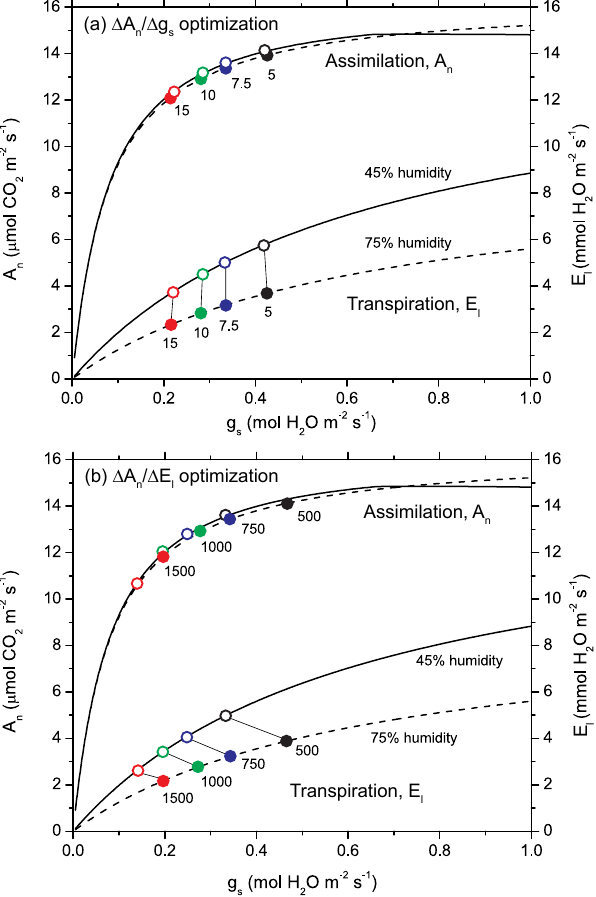
Figure 3. Leaf assimilation ( A n , left-hand axis) and leaf tran- spiration ( E l , right-hand axis) in relation to imposed values of stomatal conductance ( g s , bottom axis). Panel (a) shows SPA- iWUE optimization and (b) shows SPA-WUE optimization. Re- sults are for a warm, sunny day with relative humidity equal to 45% (solid lines) and 75% (dashed lines). Circles denote op- timized values for A n , E l , and g s at which (a) 1A n /1g s = 5, 7.5, 10, and 15µmolCO 2 mol − 1 H 2 O (iWUE optimization) and (b) 1A n /1E l = 500, 750, 1000, and 1500µmolCO 2 mol − 1 H 2 O (WUE optimization). Open circles are with 45% relative humidity. Filled circles are with 75% relative humidity.